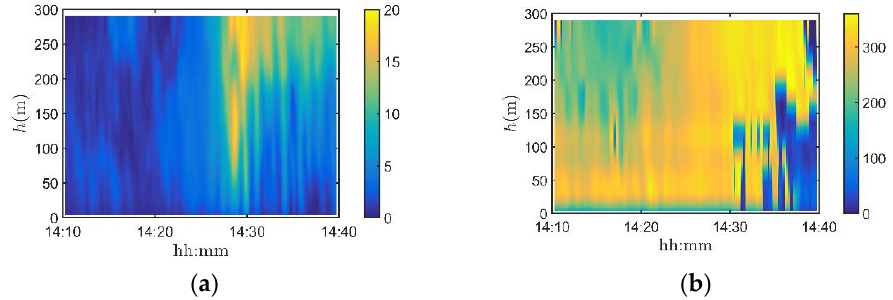
Figure 8. Spatial – temporal variation of slowly-varying mean wind speed ( a ) and direction ( b ). Figure 8. Spatial–temporal variation of slowly-varying mean wind speed ( a ) and direction ( b